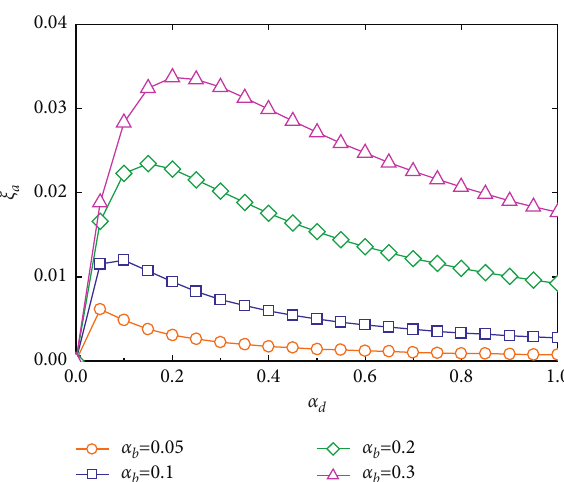
1 , α 2 with the stiffness ratio α for η